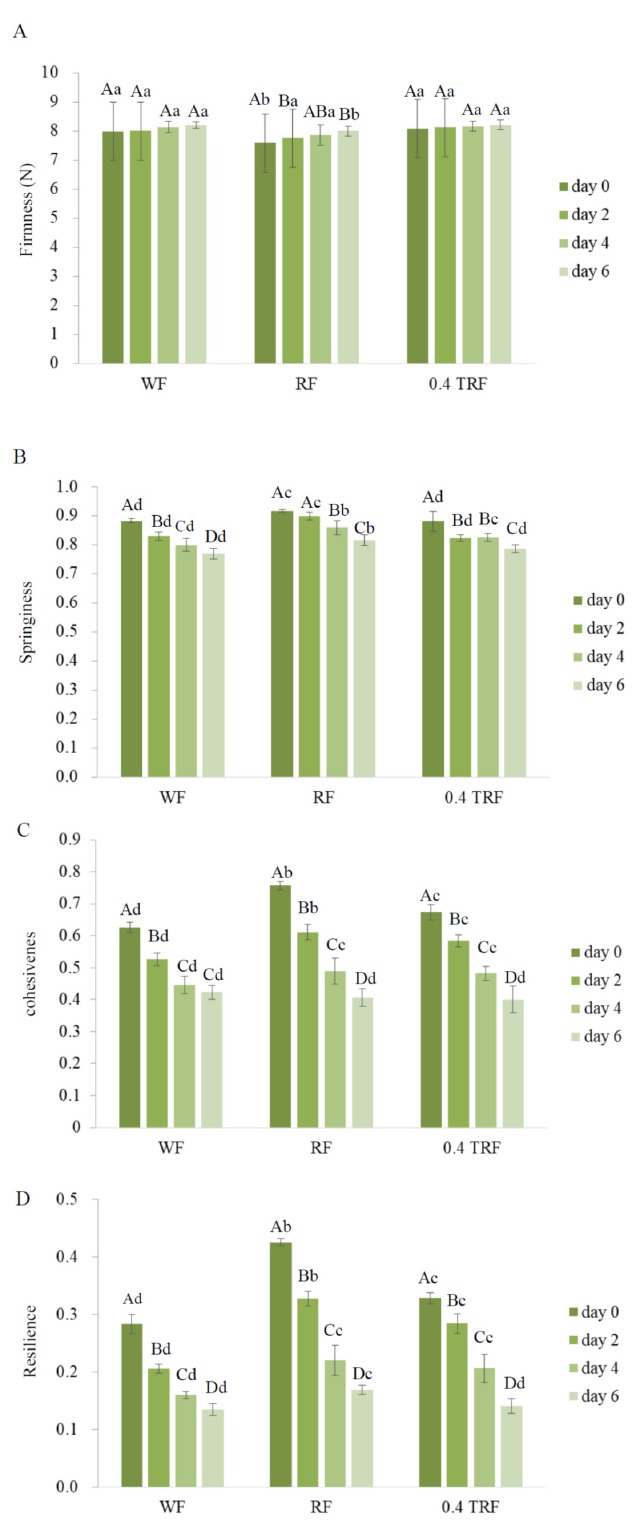
Figure 3. Texture parameters of cake and gluten-free cake: firmness ( A ), springiness ( B ), cohesiveness ( C ) and resilience ( D ). a-c Di ff erent letters indicate significant di ff erence between di ff erent samples (n = 3; p < 0.05). A-D Di ff erent letters indicate significant di ff erence between di ff erent days (n = 3; p < 0.05). WF: cake made with 100% wheat flour; RF: gluten-free cake made with 100% rice flour; 0.4 TRF: gluten-free cake with 0.4% tamarind seed gum